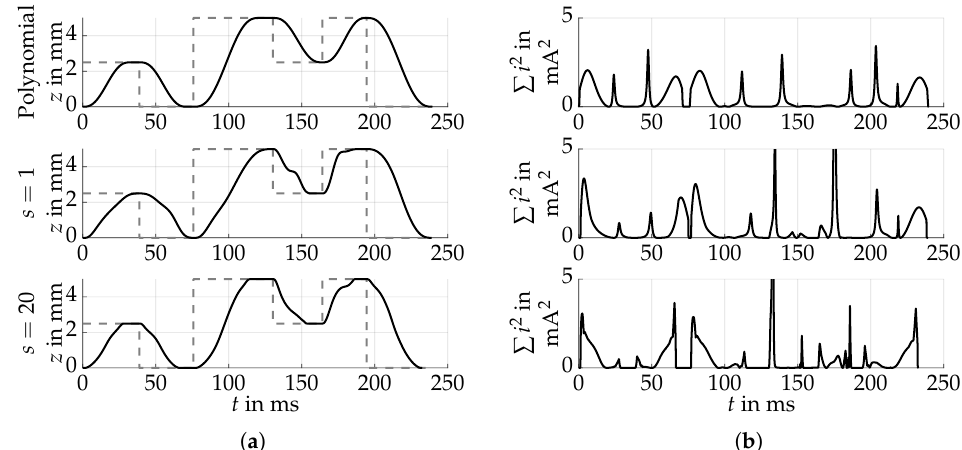
Figure 10. Comparison of trajectories and respective currents with different numbers of optimization variables. ( a ) Top panel: for the polynomial trajectory, smooth motions were generated and the transition times were optimized. Middle panel: the trajectory with two parameters σ s and optimized transient time is less smooth but has lower costs. Bottom panel: the lowest costs were achieved with 20 parameters σ s . The dashed line corresponds to the desired final position of the proof mass. ( b ) The sum of squared currents corresponding to the different trajectories is shown. For the trajectory with 20 parameters, the solution is non-smooth due to fast changes in the current, but the transient time and the sum of squared currents are the